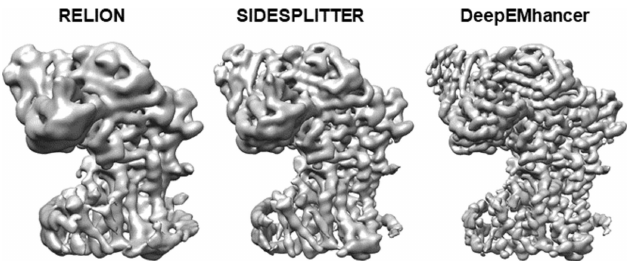
Figure 2 Refinements of 37814 particle images of AftD in lipid nanodiscs (EMPIAR-10391). Comparison of refinement results using standard RELION , SIDESPLITTER and deepEMhancer . No local filtering or sharpening operations were used and the threshold is set to keep the enclosed volume